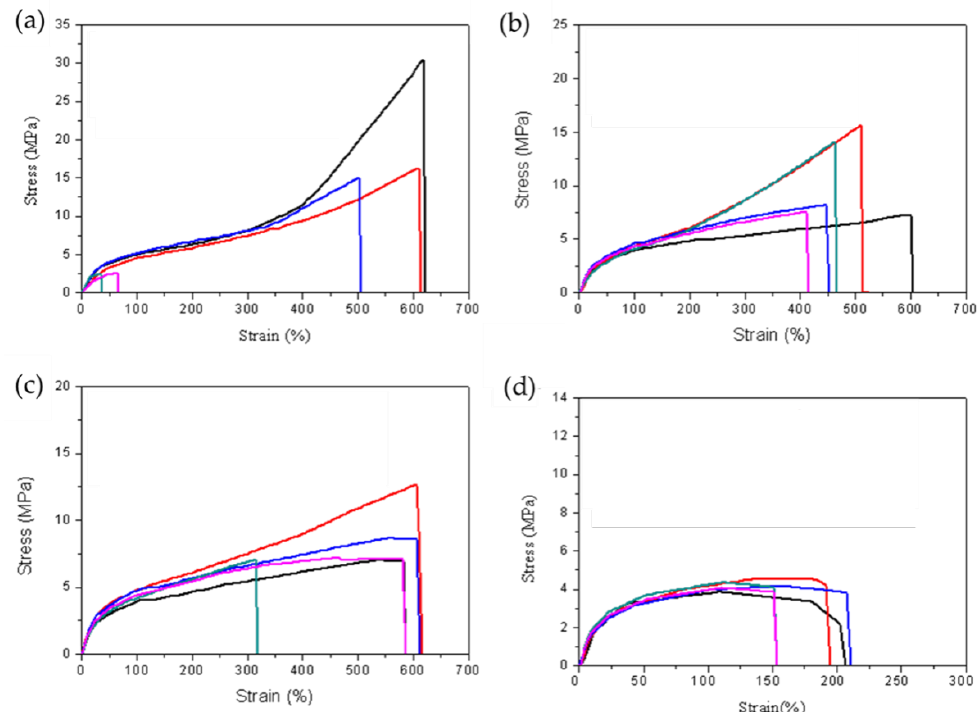
Figure 9. Self-healing properties of ester TPU/phenoxy blends: ( a ) blends without the catalyst; ( b ) blends with zinc acetate as the catalyst; ( c ) blends with DBTDL as the catalyst; ( d ) blends with TBD as the catalyst. Colored lines represent samples of different composition and thermal history: ( ━ ) Pristine ester-type TPU; ( ━ ) Ester TPU90/10 after heat treatment at 150 °C; ( ━ ) Ester TPU80/20 after heat treatment at 150 °C; ( ━ ) Ester TPU90/10 after cut and heal at 150 °C; ( ━ ) Ester TPU90/20 after cut and heal at 150 °C. Table 3. Summary of the tensile properties and healing e ffi ciency of TPU / phenoxy blends after heat treatment at 150 ◦ C.